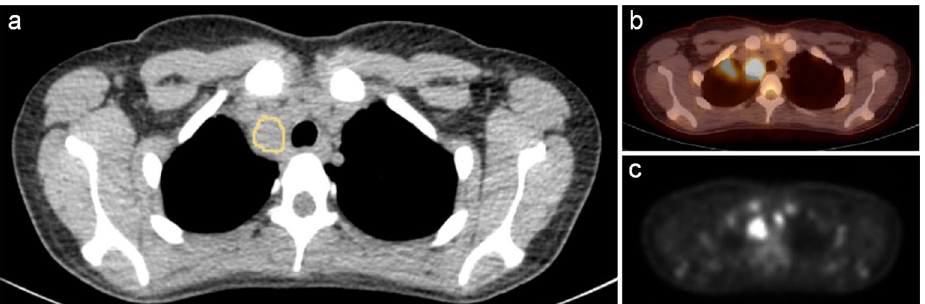
Figure 1. Illustration of ROI placement. ( a – c ) A 20-year-old female patient with the initial diagnosis of Hodgkin’s lymphoma. Image a shows an example slice of a 3D ROI segmenting a lymphoma manifestation in the upper mediastinum. PET/CT ( b , c ) show this manifestation to be FDG-positive. Readers were required to include as much lymphoma manifestation as possible while keeping a distance of 1–2 pixels from the edge. A slight misalignment is also visible in ( b ), which we corrected when we copied the segmentation mask from the CT to the PET